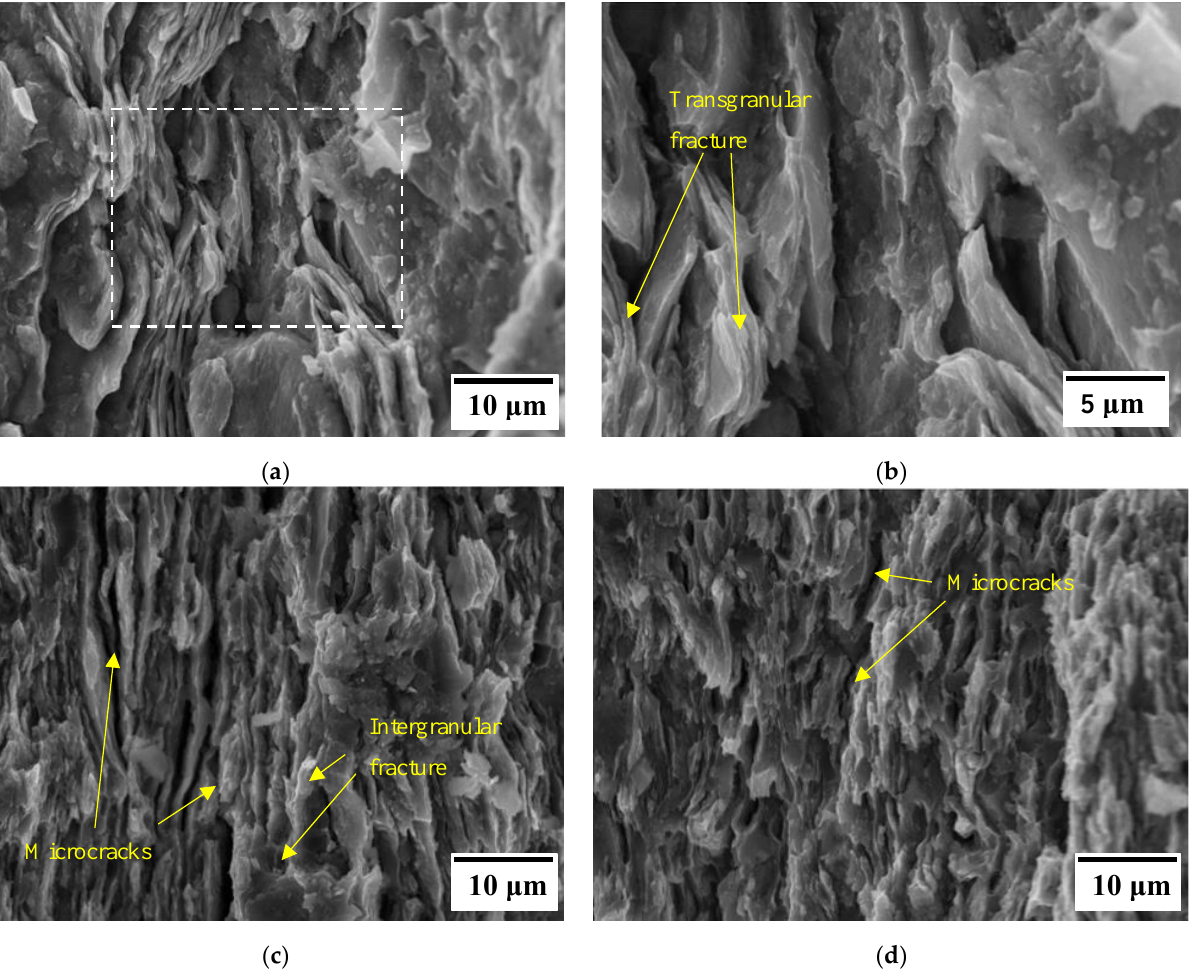
Figure 8. Fracture surface FESEM images of sintered samples: ( a ) AA7075; ( b ) boxed area in ( a ); ( c ) 15G1-S; ( d ) 15G2-S.